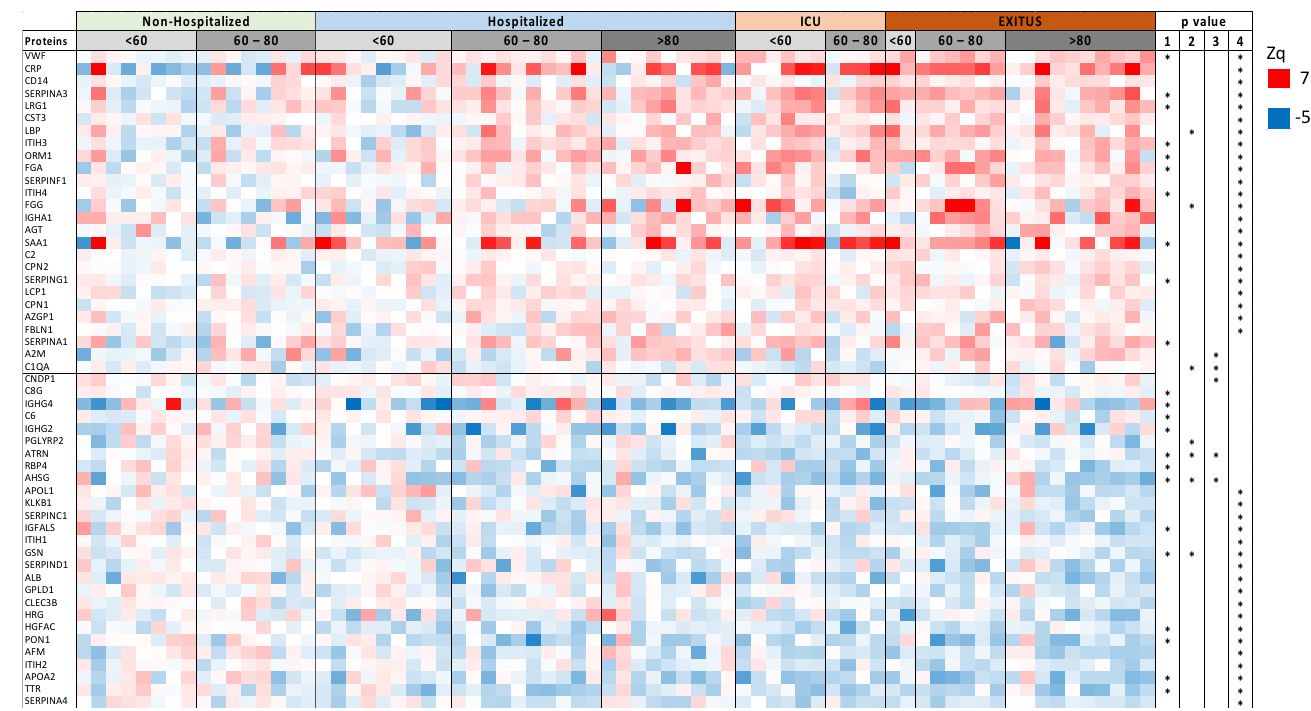
Figure 2. Proteins differentially regulated with disease severity. The heatmap shows protein abun- dance changes (expressed as Zq, or standardized log2-ratios) normalized by the average values of the non-hospitalized patient group. Statistical significance of changes ( p -value) is calculated using two-tailed Student’s t -test. Proteins (quantified with more than one peptide and in the 80% in the individuals) whose abundance is significantly ( p -value < 0.05) increased (red) or decreased (blue) at least in one comparison are shown (1 = Non-Hospitalized vs Hospitalized, 2 = Hospitalized vs ICU, 3 = ICU vs EXITUS, 4 = Non-Hospitalized vs EXITUS).